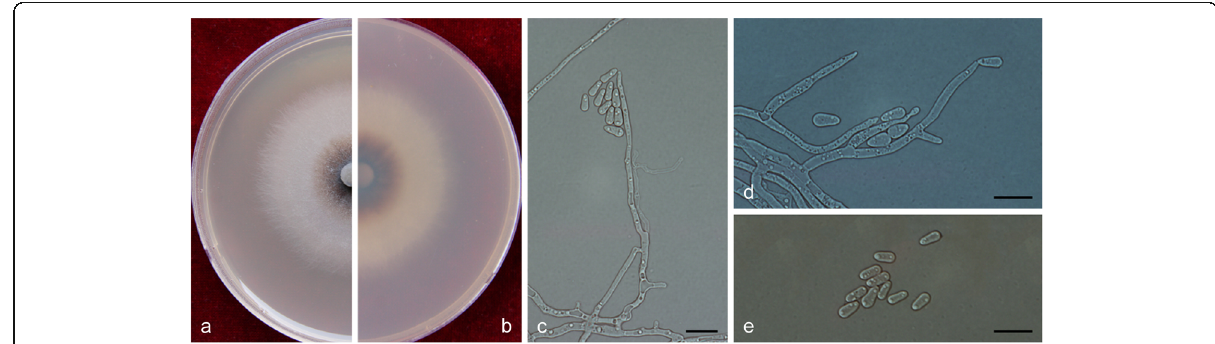
Fig. 18 Morphological characteristics of Ophiostoma subelongati sp. nov. (CFCC 52693, Taxon 10). a – b. Five-day-old cultures on 2% MEA; c – e. Hyalorhinocladiella-like asexual morph: conidiogenous cells and conidia. Scale bars: c – e = 10 μ